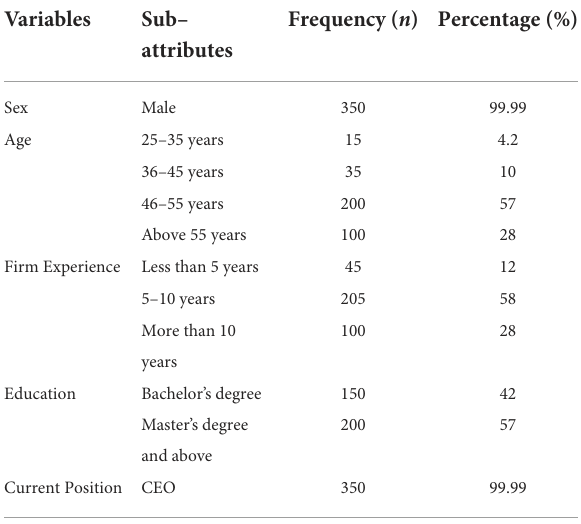
TABLE 2 Characteristics of the